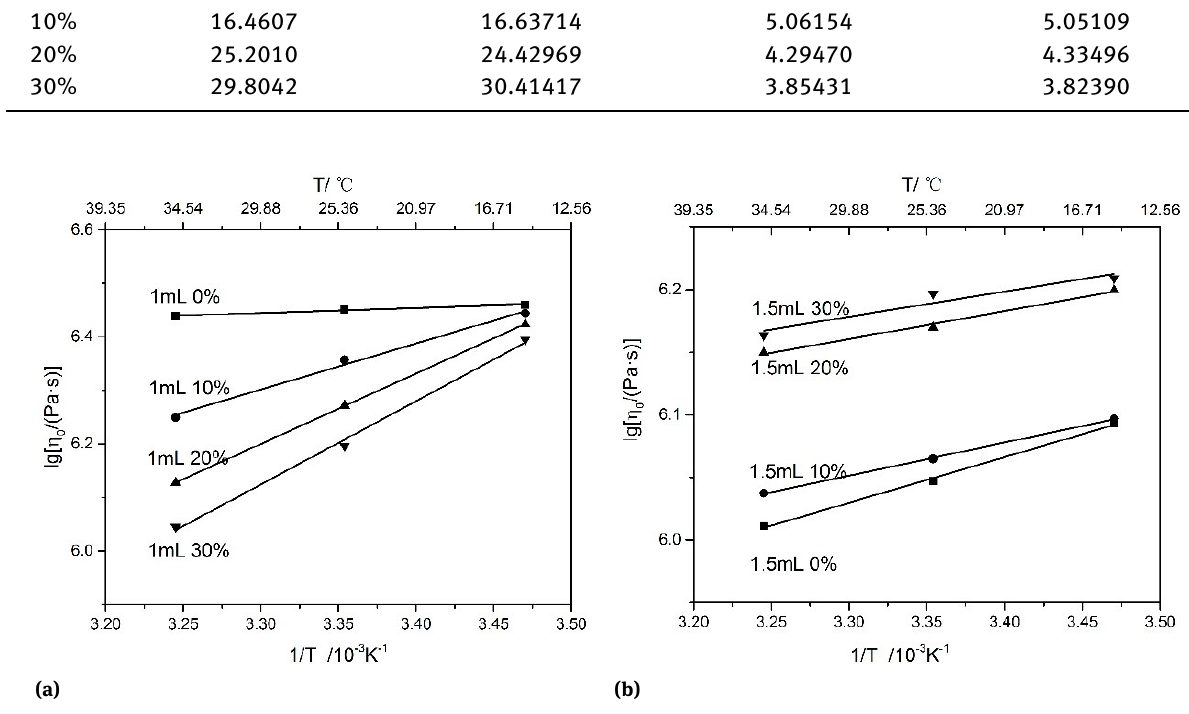
Figure 6: lg[ η 0 /(Pa · s)] vs. 1/T at different concentration of